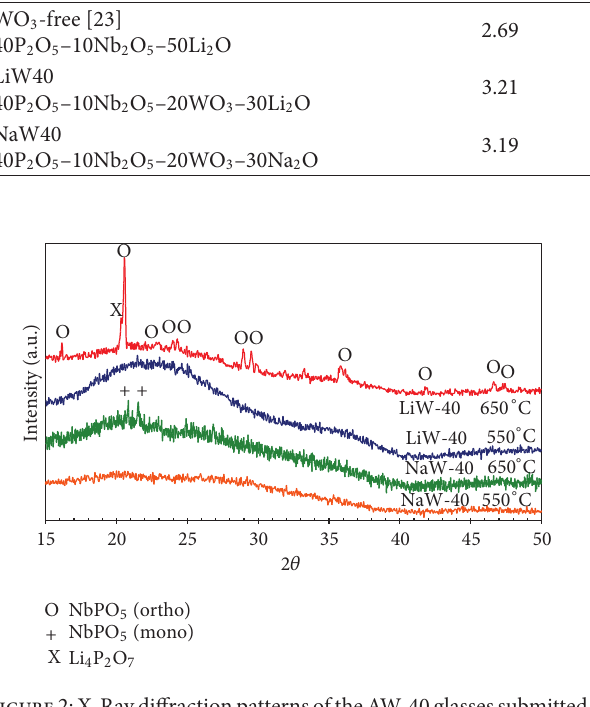
F2: X-RaydiffractionpatternsoftheAW-40glassessubmitted to different heat treatments.